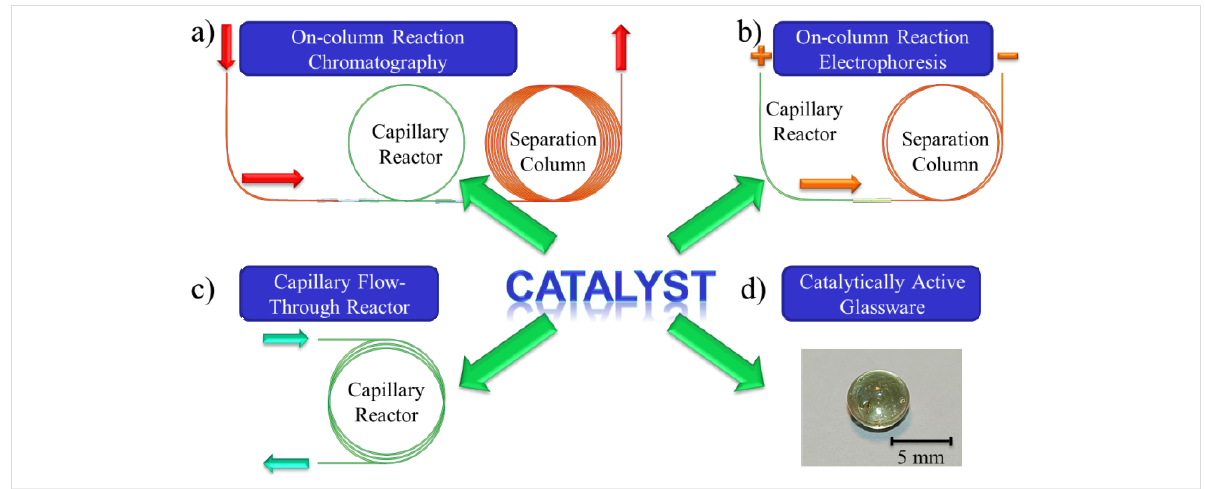
Figure 1: Overview of some capabilities of an immobilized or in an inert stationary phase dissolved catalyst. The use of reactive capillaries a) in on-column reaction GC, b) in on-column reaction capillary electrophoresis, c) as a capillary reactor to perform flow-through experiments, and d) to obtain catalytically active